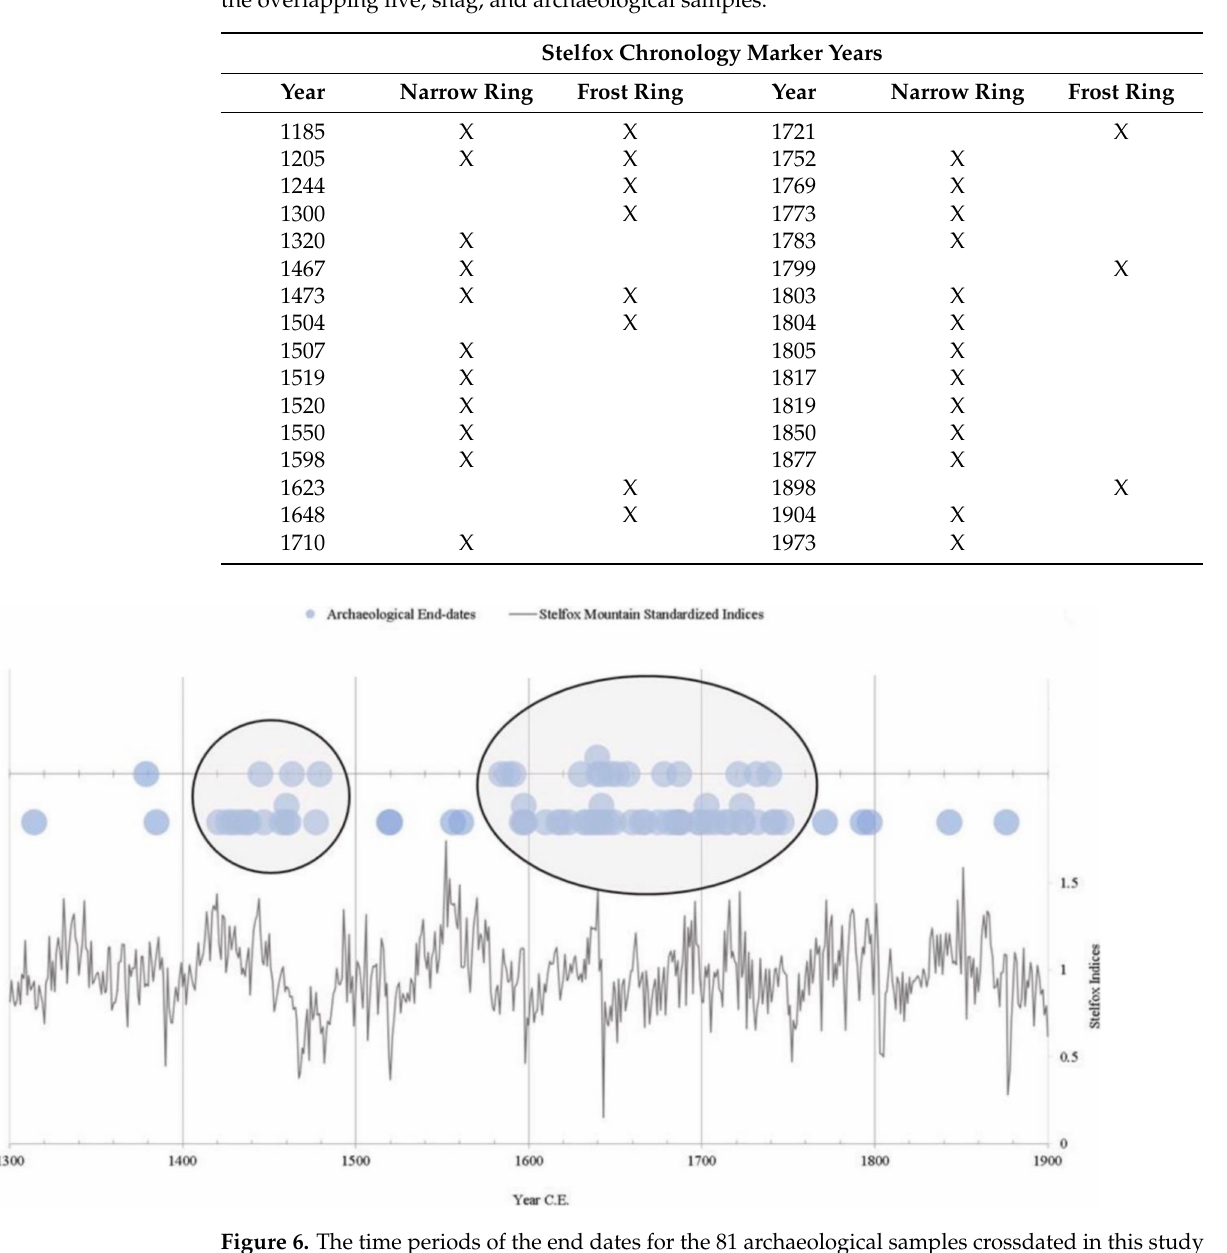
Figure 6. The time periods of the end dates for the 81 archaeological samples crossdated in this study are represented by blue dots. The end dates are spread over a period from 1314 until 1876 C.E., but most of the samples cluster into two time periods, 1421–1477 and 1597–1746